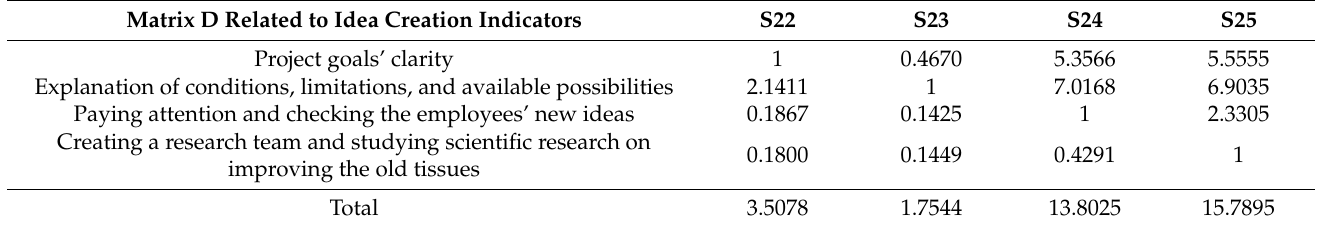
Table 20. Pairwise comparison matrix related to idea creation indicators.